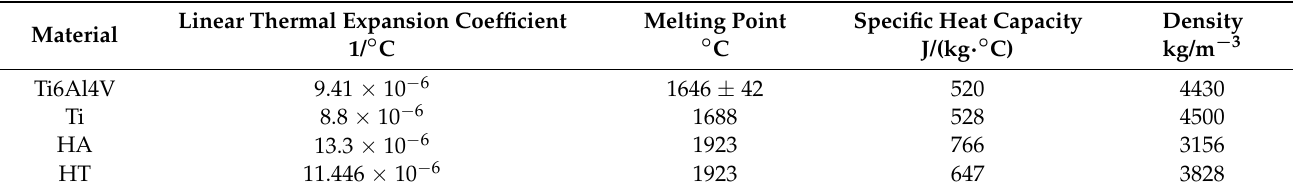
Table 2. Thermo-physical parameters of Ti6Al4V, Ti, HA, and HT at room temperature.